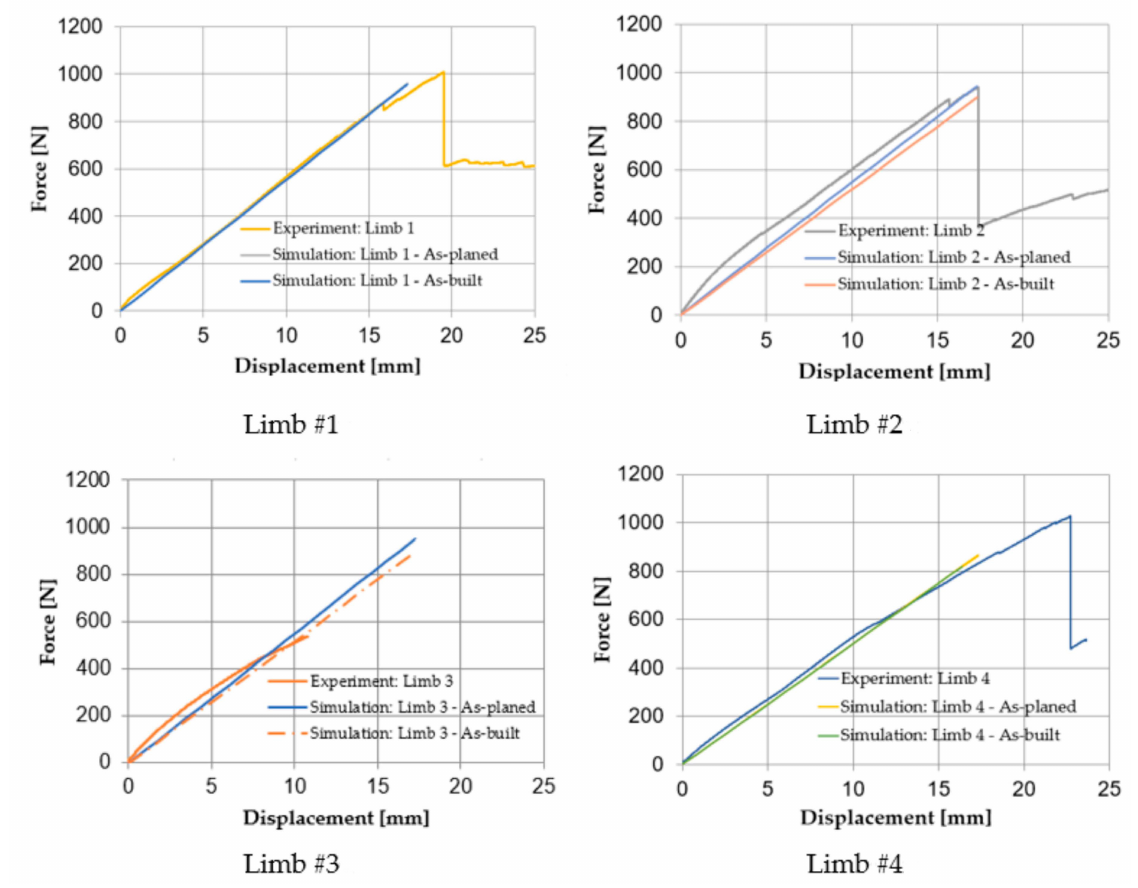
Figure 17. Direct validation of the as-built simulation models by comparison with the as-planned